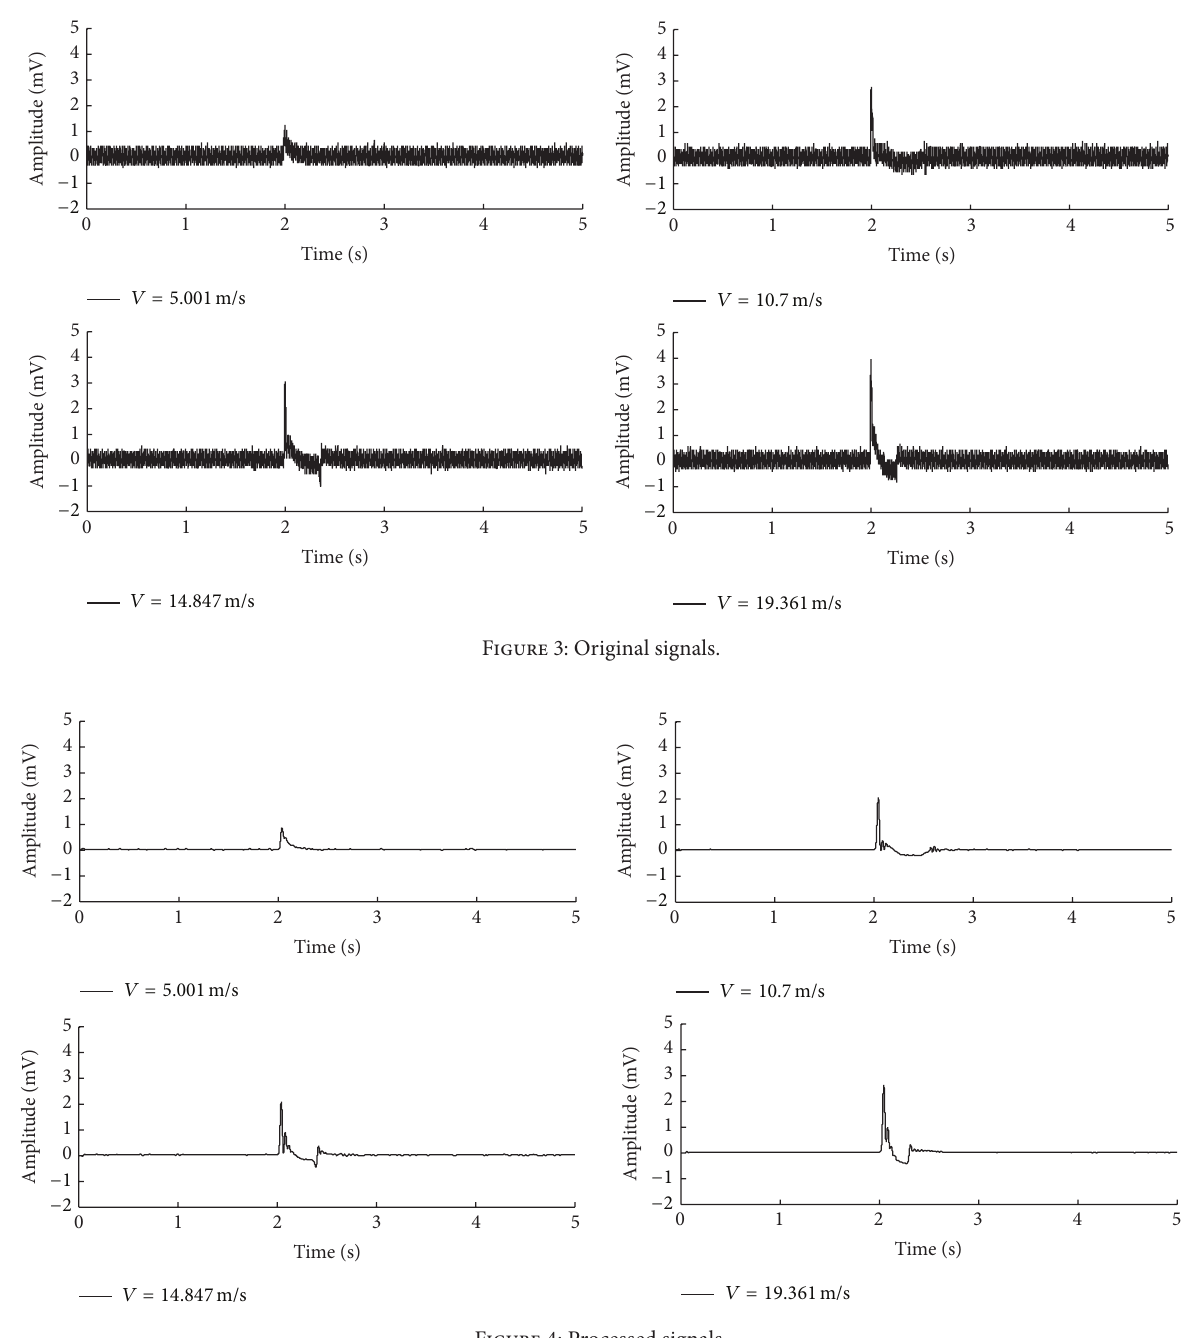
Figure 3: Original signals.